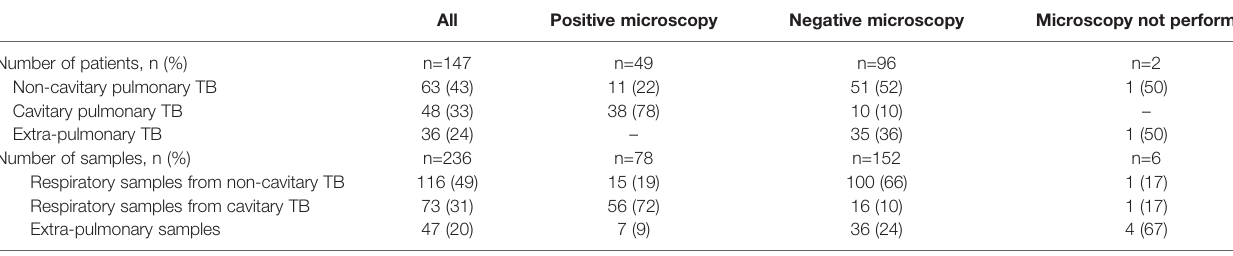
TABLE 3 | Results of microscopy, overall and by clinical presentation.